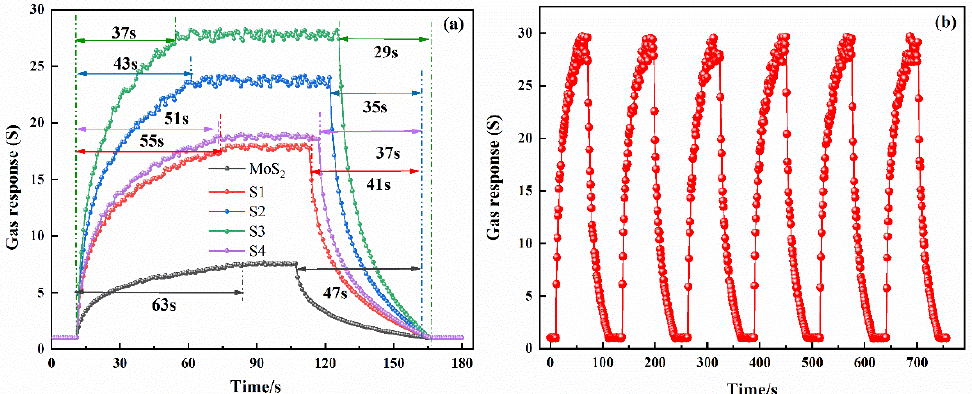
Figure 10. ( a ) Dynamic response–recovery characteristic curve of each gas-sensing material to 15 μL/L